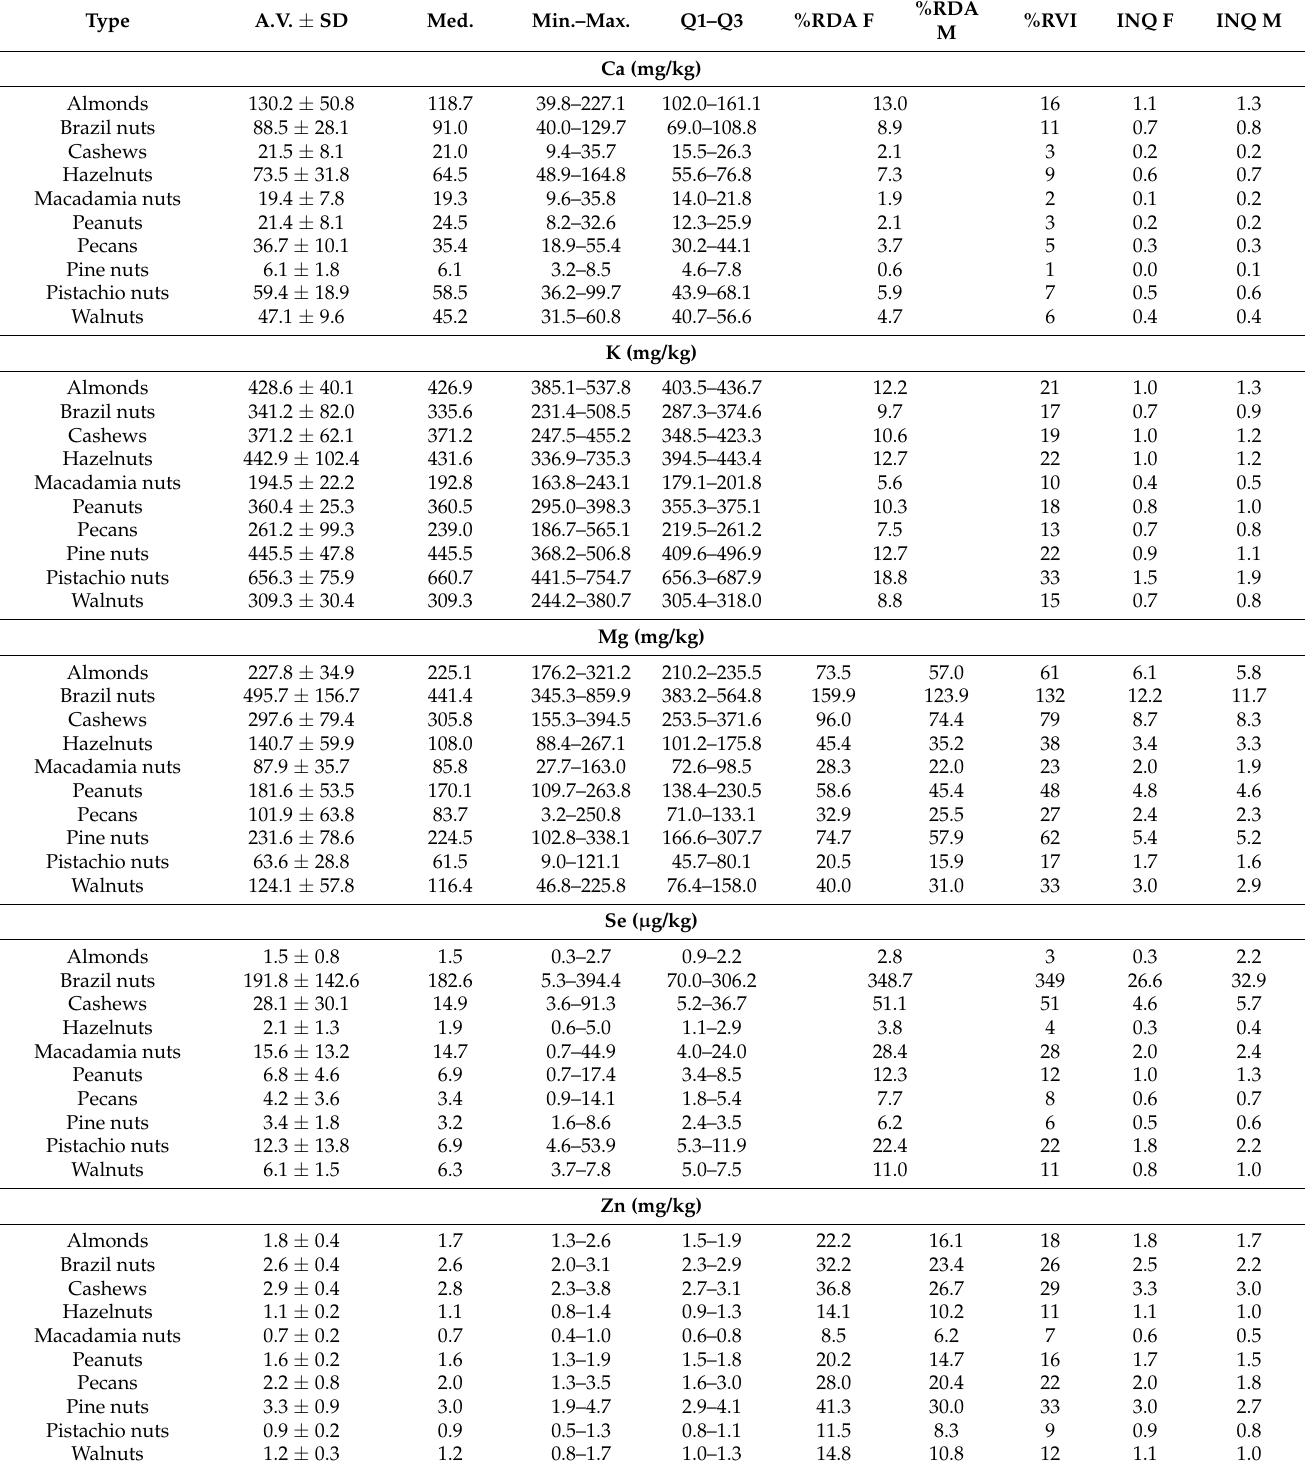
Table 2. The content of the tested elements in a standard portion of nuts weighing 42 g and percent of RDA, RVI, and INQ for